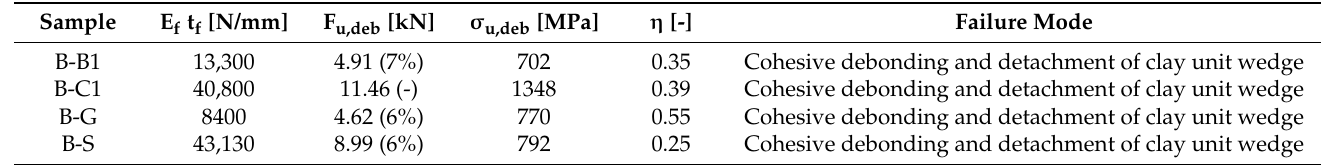
Table 4. Experimental results: clay unit substrate—BFRP, CFRP1, GFRP, and BFRP.